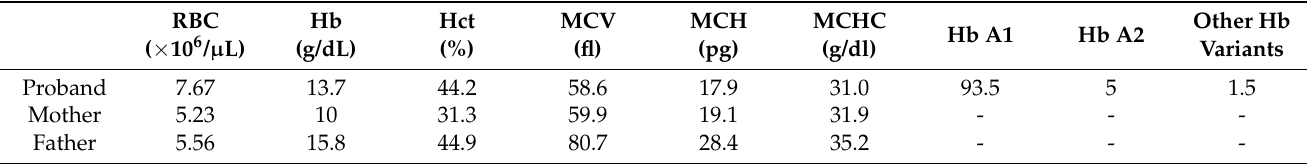
Figure 1. The capillary electrophoresis pattern of the case with co-inheritance of HBB: c.315 + 1G > A and HBA1: c.154G > T mutations. Table 1. Haematological indices of a case with co-inheritance of c.315 + 1G > A mutation of